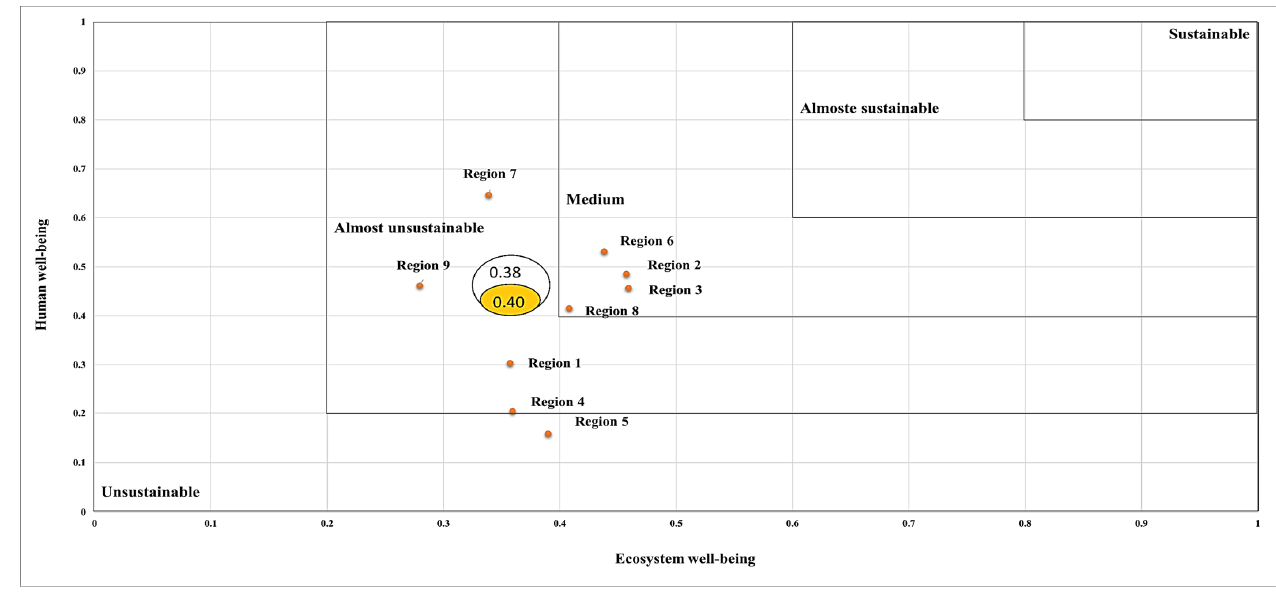
Figure 11. Barometer of s ustainability.